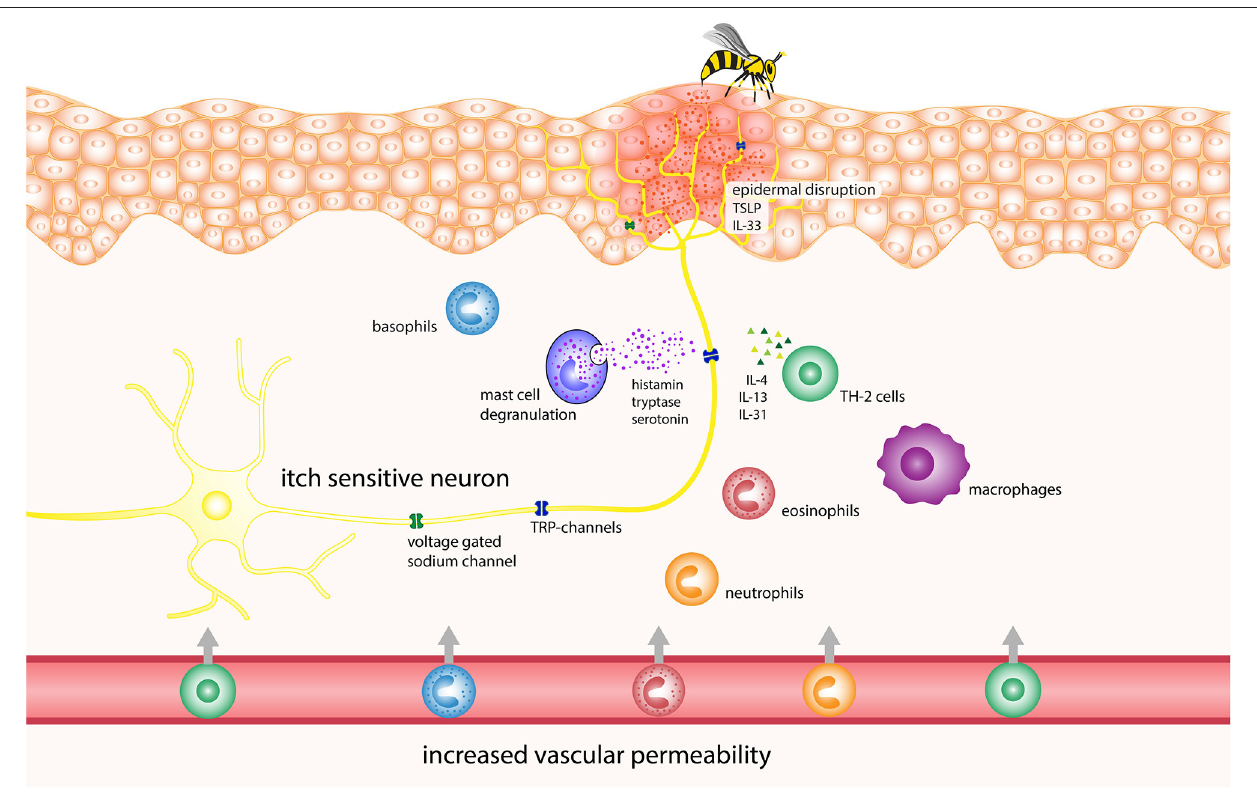
FIGURE 1 | Potential pathophysiology of itch induction in Hymenoptera stings. IL, interleukin; TRP, transient receptor potential channels.